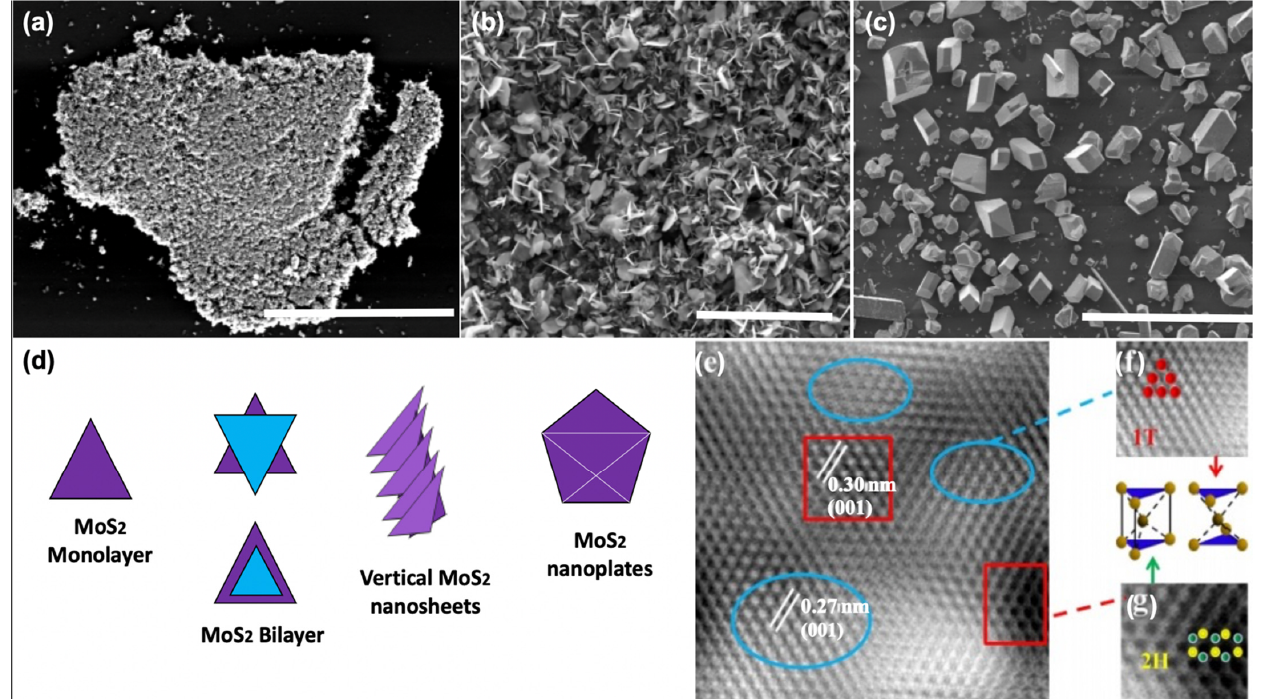
Figure 4. Examples of MoS 2 microstructures: ( a ) planar triangle flakes scale = 40 µm; ( b ) vertical nanosheets scale = 100 um; ( c ) vertical nanoplates scale = 100 µm; ( d ) schematic of the nucleation process of MoS 2 ; ( e ) HRTEM image of mixed 1T-MoS 2 and 2H-MoS 2 ; ( f ) zoom in of blue circled region of the 1T-MoS 2 structure, with the unit cell of the 1T phase; and ( g ) zoom in of red circled region of the 2H-MoS 2 structure, with the unit cell of the 2H phase. (Figure 4e–g adapted from Ref. [131] Copyright 2019, Springer Nature.)